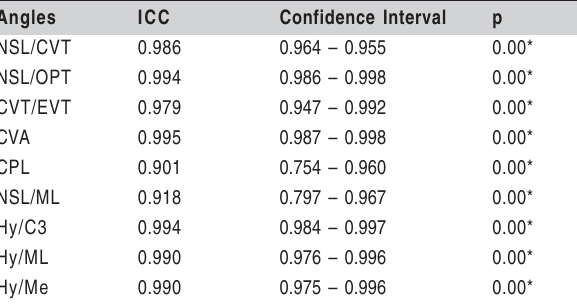
Table 1 - Intra-examiner reliability of the